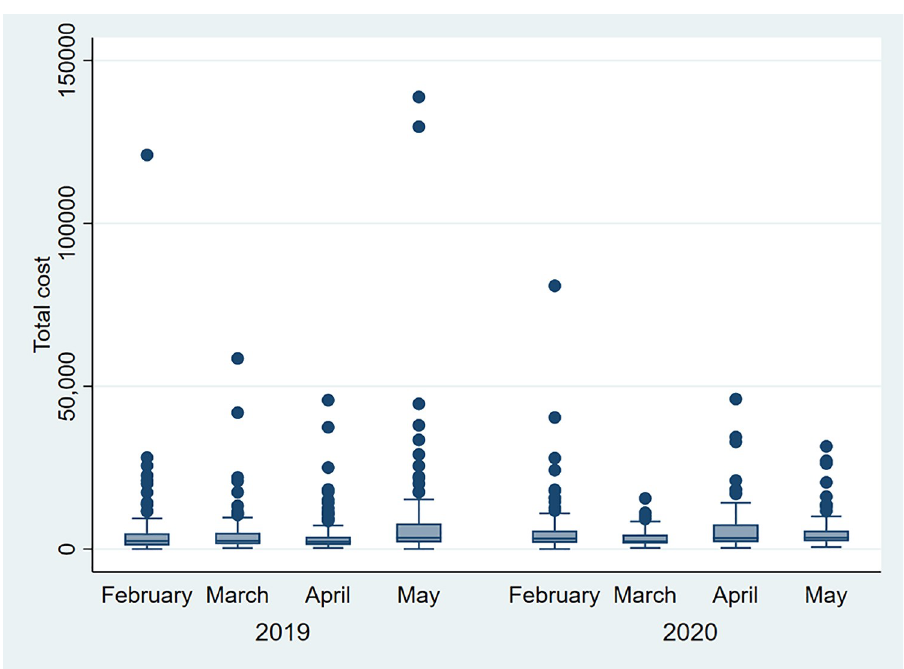
Fig 2. Costs for emergency general surgery admissions. Monthly evolution of total per-person healthcare costs for unplanned general surgery admissions during two periods: 02-05/2019 (pre-pandemic) and 02-05/2020 (COVID19